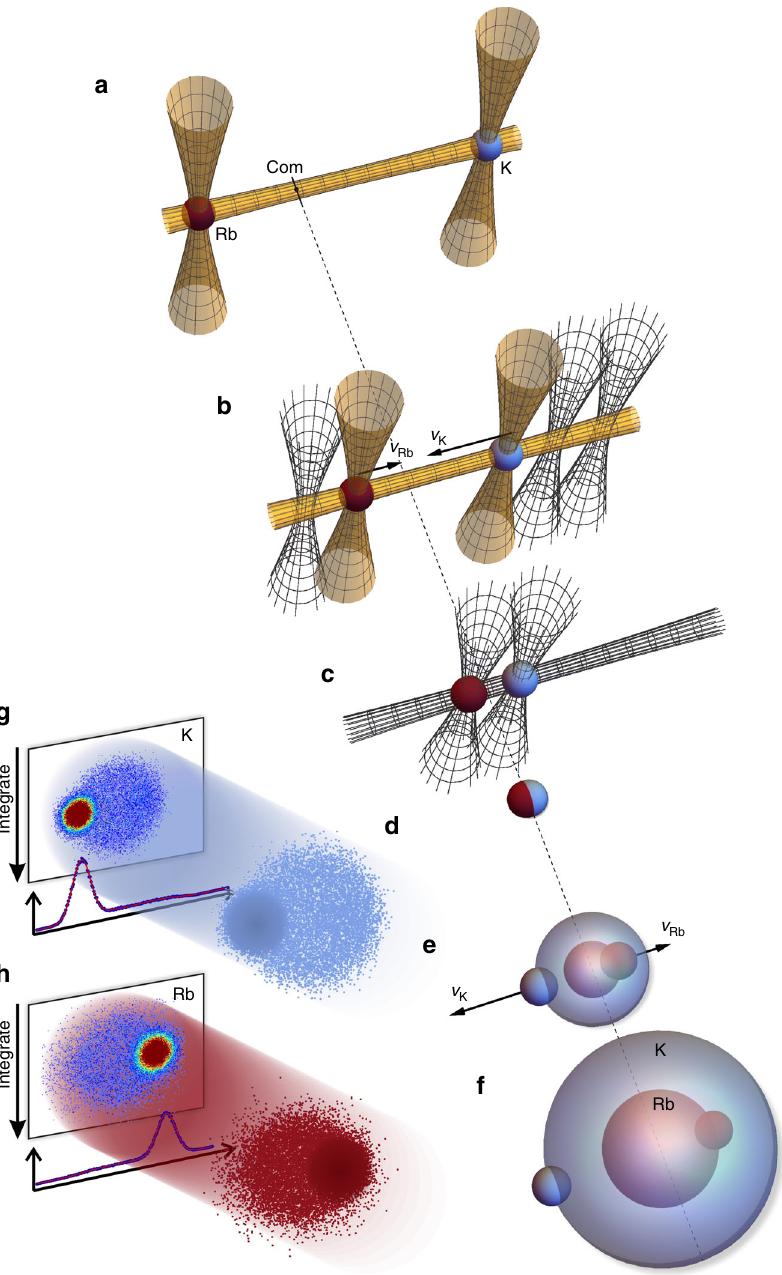
Fig. 2 Optical collider procedure. a 40 K (blue, right) and 87 Rb (red, left) atoms, prepared in the desired internal quantum states, are held in two crossed optical dipole traps separated by ~3 mm; COM indicates the centre-of-mass for pairs of K and Rb atoms. b The two traps are accelerated towards each other, keeping m Rb v Rb = − m K v K , so that pairs of of K and Rb atoms have zero total momentum on average, and their COM is at rest in the laboratory frame. c When the wells are separated by ≈ 60 μ m, the optical traps are switched off. d The two clouds collide in free space. e , f The K and Rb collision halos expand at different rates. We image the K halo at the time represented in e , and then wait to image Rb until its halo has expanded to the equivalent size ( f ). g , h 3D collision halos of K ( g ) and Rb ( h ) are projected onto a 2D plane by the process of absorption imaging. We integrate the projected images in the vertical direction to obtain line densities. Line densities are fi tted to extract the scattered